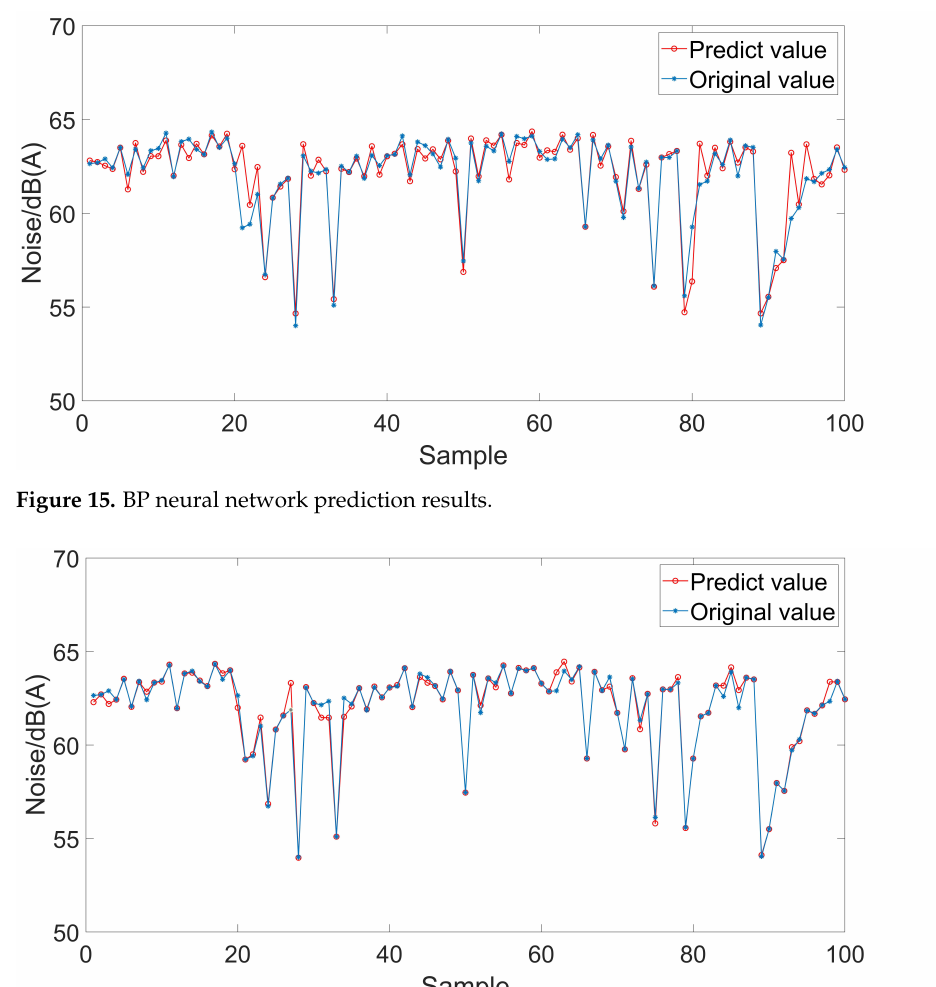
Figure 16. GA-BP neural network prediction